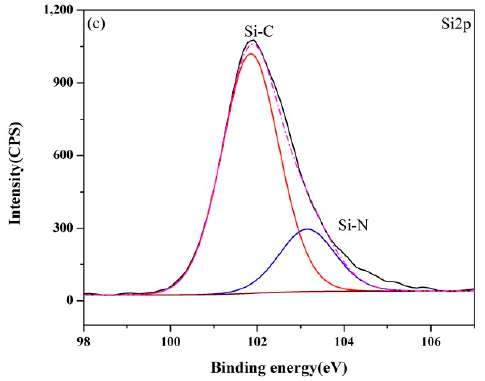
Figure 8. XPS core-level spectra of sample C synthesized at 1550 °C: ( a ) C1s, ( b ) N1s and ( c ) Si2p.